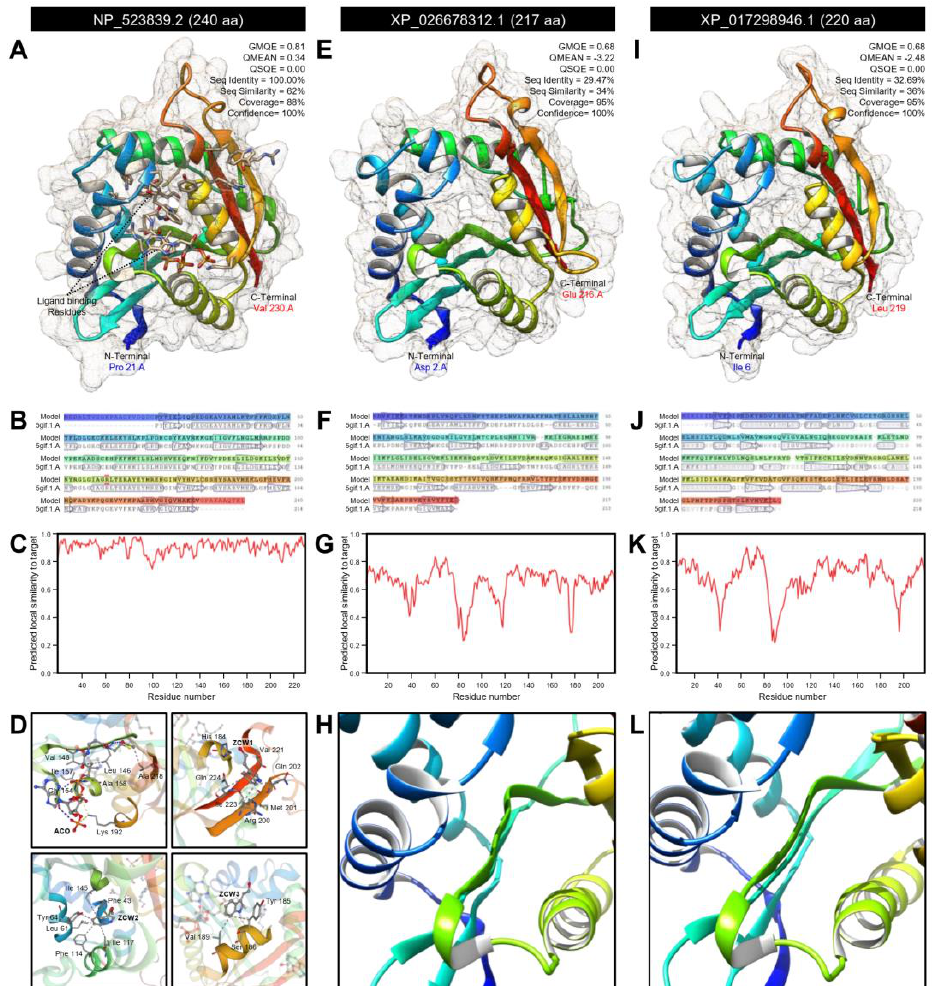
Figure 9. The crystallographic three-dimensional (3D) modeling of arylalkylamine N-acetyltransferase ( DcAANAT ) of Diaphorina citri . ( A , E , I ) The predicted three-dimensional (3D) structure model and its associated mesh surface of DmAANAT (NP_612080.1), DcAANAT -1 (XP_026678312.1), and DcAANAT -2 (XP_017298946.1), respectively. The tertiary structures were predicted with 100.0% confidence by the single highest scoring template of the crystal structure of D. melanogaster dopamine N-acetyltransferase in complex with CoA and tryptophol (PDB ID: 6k80.1.A) and refined to 1.28 Å resolution. Protein chains are colored according to the rainbow color spectrum, from blue (N-terminus) to red (C-terminus). ( B , F , J ) Model–template alignment of DmAANAT , DcAANAT -1, and DcAANAT -2, respectively. AA sequences of each model were aligned with the template (6k80.1.A). Secondary structures are represented by rectangles ( α -helices) and arrows ( β -sheets). Matched sequences are indicated in black. ( C , G , K ) Local quality estimate of the predicted models of DmAANAT , DcAANAT -1, and DcAANAT -2, respectively. ( D , H , L ) Close-up of the ligand-binding site of DmAANAT , DcAANAT -1, and DcAANAT -2, respectively. The selected poses were oriented to show the entry point for acetyl coenzyme A (ACO) and 2-(1H- indol-3-yl)ethanol (ZCW). Some surrounding AA near to the ligand are shown with their residue number. Gray dotted-lines indicate hydrophobic interactions, blue dotted-lines indicate hydrogen bonds, yellow dotted-lines indicate salt bridges, and green dotted-lines indicate pi-Stacking. All bioinformatics analyses were carried out based on recent available data on the “ Diaphorina citri OGS v2.0 proteins” dataset available on Citrus Greening Solutions website (https://citrusgreening.org/organism/Diaphorina_citri/genome, 12 February 2021) and the most recent available data in GenBank, the national center for biotechnology information website (NCBI, http://www.ncbi.nlm.nih.gov/gene/, 12 February 2021). The 3D structure was created using the SWISS-MODEL server (https://swissmodel.expasy.org/, 12 February 2021) and visualized using